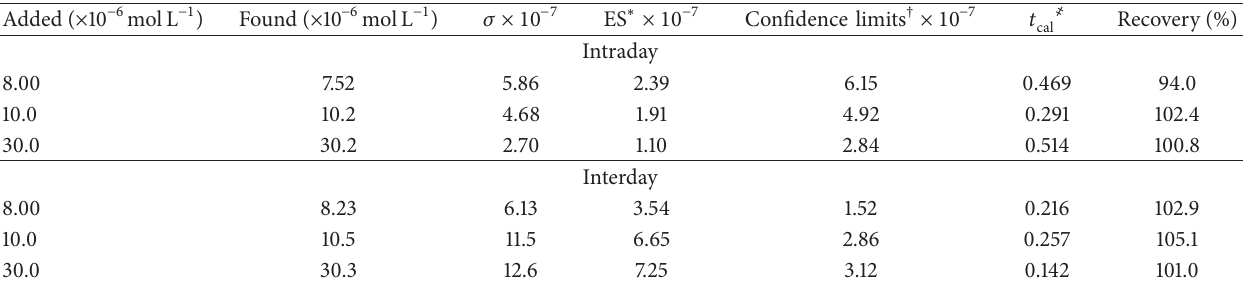
Table 6: Analysis to assess precision and accuracy of the developed method for the determination of AOF intraday and interday. Added ( × 10 −6 molL −1 ) Found ( × 10 −6 molL −1